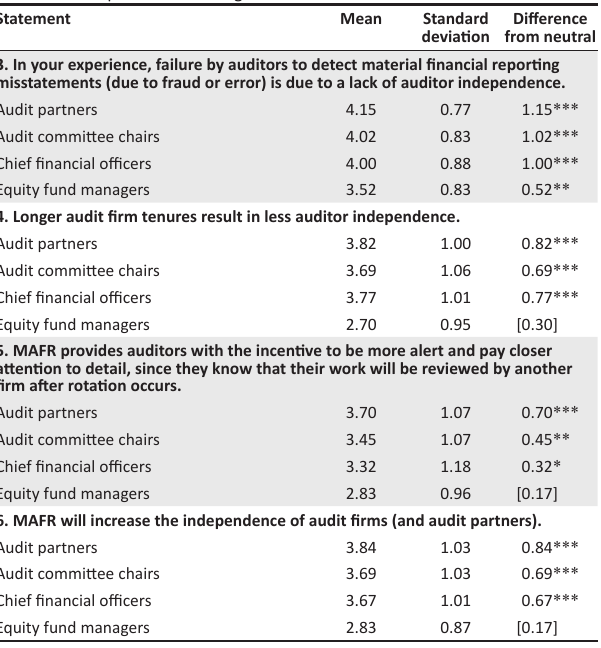
TABLE 2: Perceptions concerning audit failure and audit firm tenure.